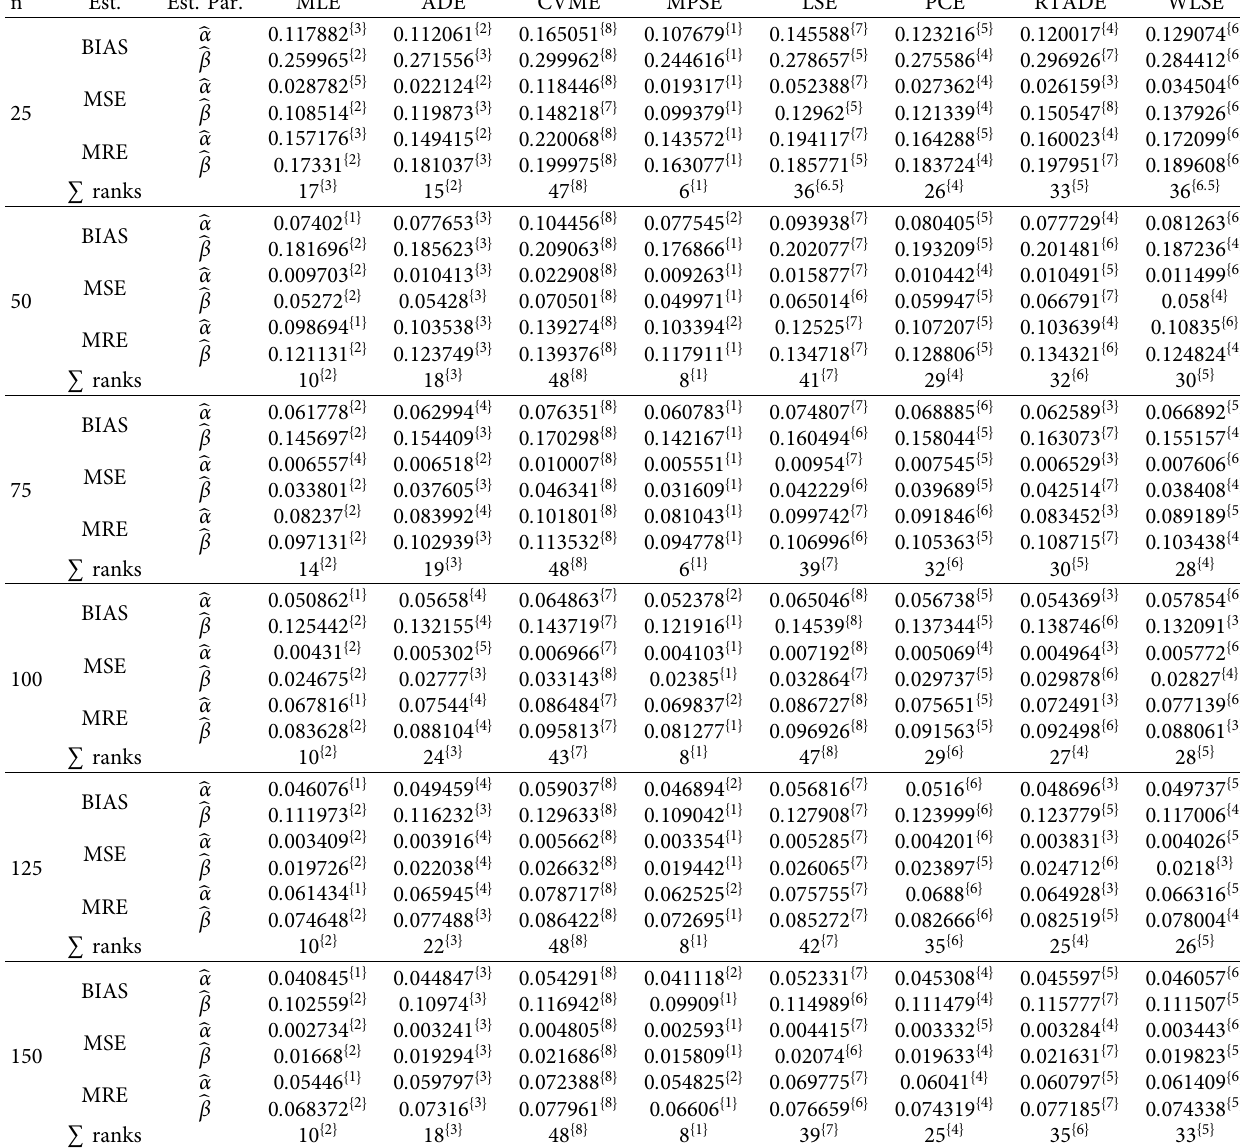
Table 2: Simulation values of BIAS, MSE, and MRE for α � 0 . 75 , β � 1 .